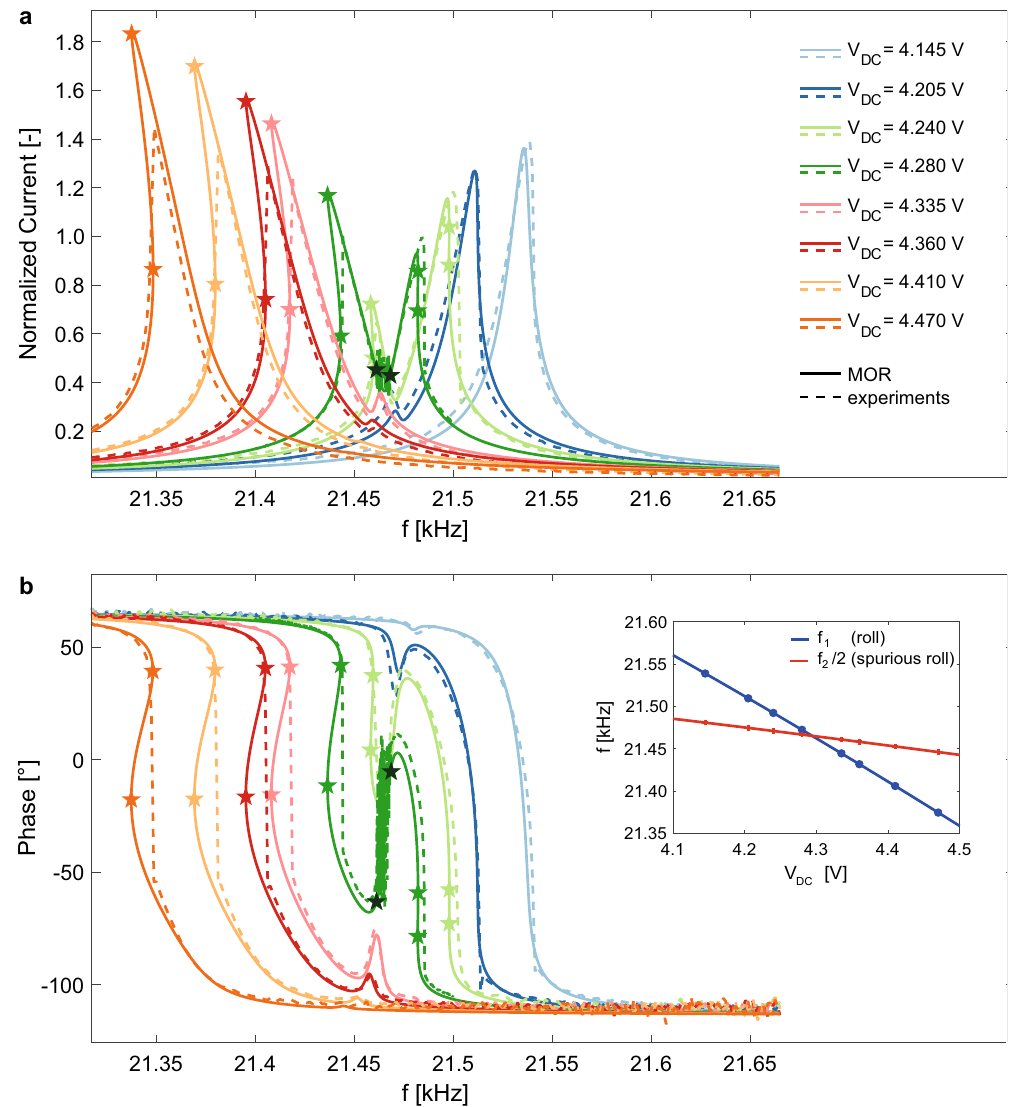
Figure 3. Frequency responses of the MEMS gyroscope test-structure for V AC = 3.16 mV and different levels of V DC in terms of ( a ) amplitude and ( b ) phase. Numerical predictions are reported in continuous lines while experiments are in dotted lines. Stars of the same color of the curves mark the Saddle–Node bifurcations estimated through the ROM model, while black stars mark the Neimark–Sacker bifurcations that delimit the quasi-periodic region of the curves at V DC = 4.28 V. The resonant frequency of the roll mode ( f 1 ) and half of the resonant frequency of the spurious roll mode ( f 2 /2) are reported in the inset for different V DC